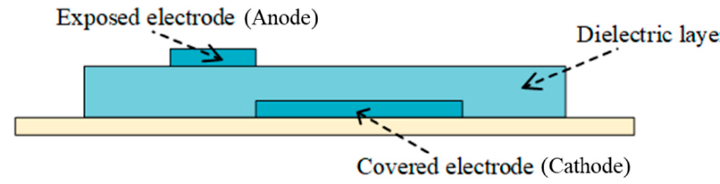
Figure 1. Structural diagram of the actuator.